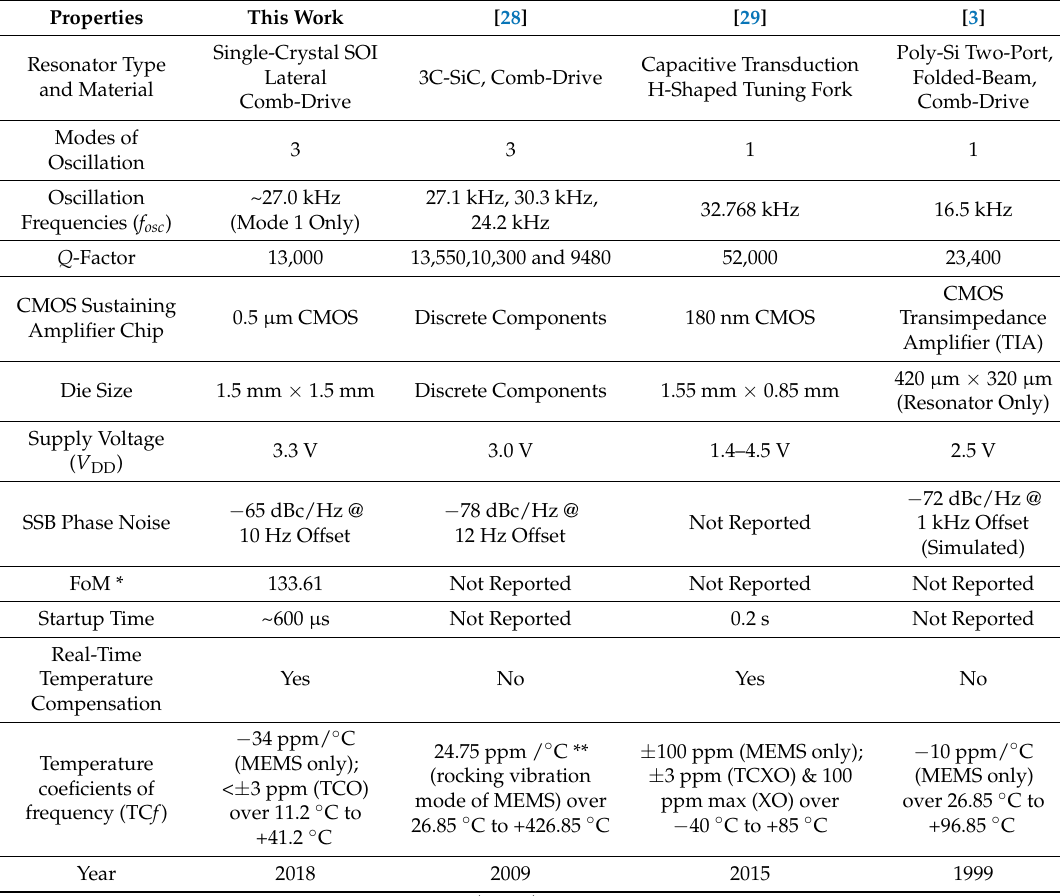
Table 3. Comparison of performance between the temperature-compensated oscillator in this work and other MEMS-referenced oscillators in the same frequency